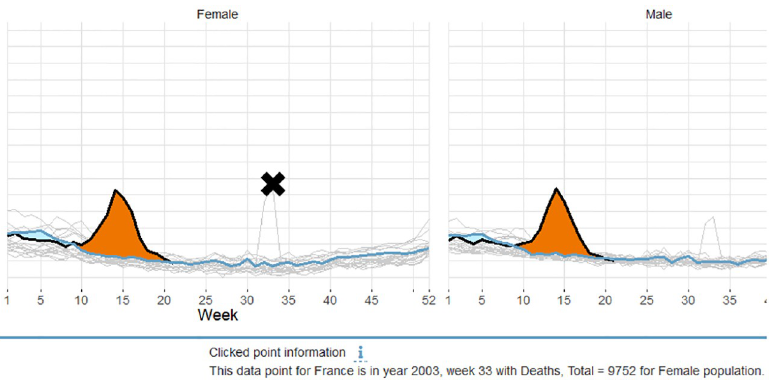
Fig 3. Summary statistics information of a selection. Information on death counts or death rates of the selected weeks by sex and type of difference are displayed below the figure.